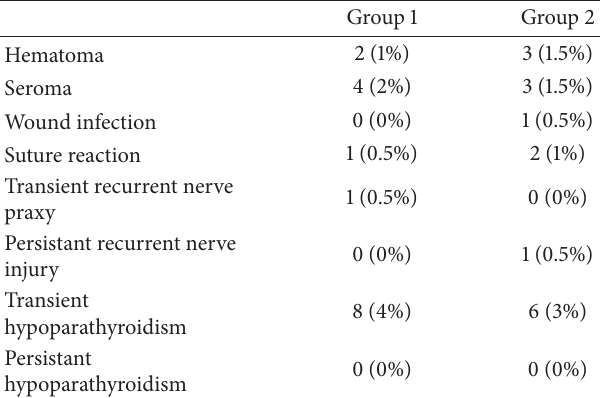
Table 4: Postoperative complications (𝑃 > 0.05 ∗ ) .